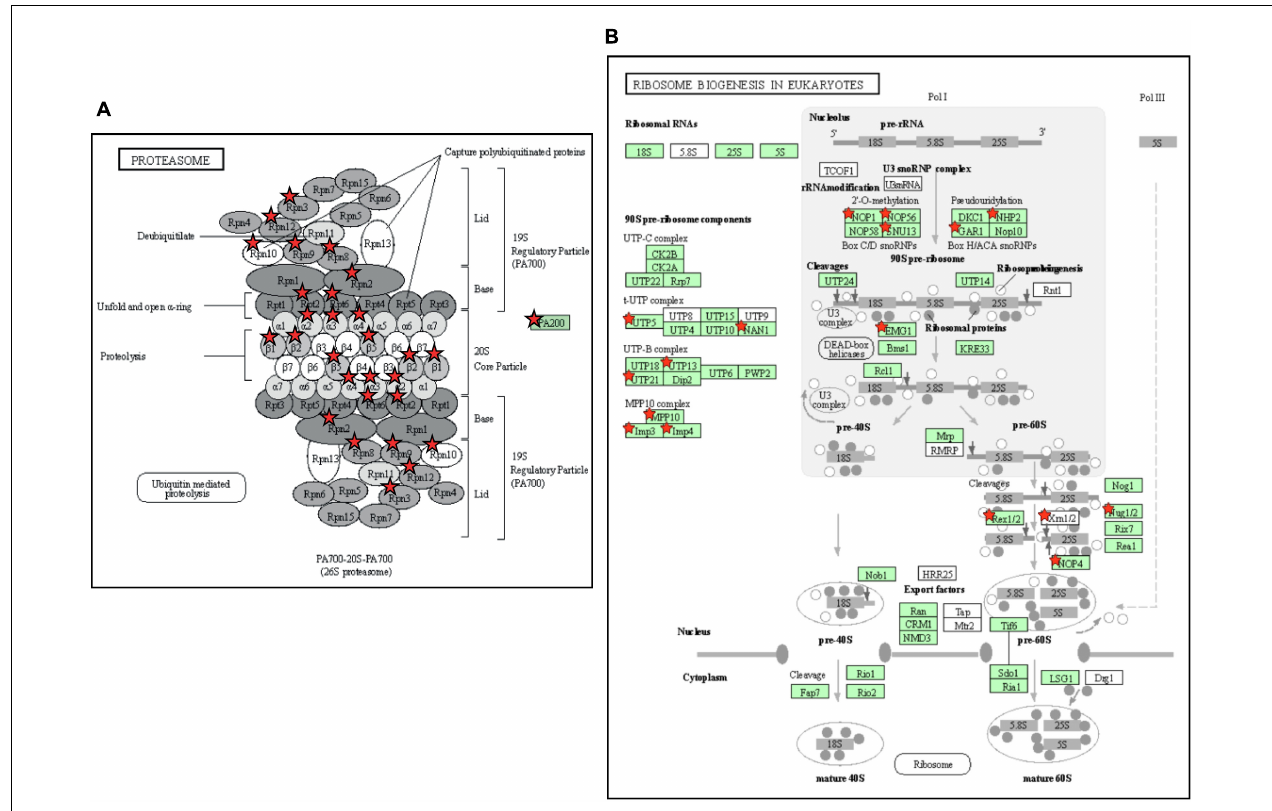
FIGURE 7 | Enrichment of pathways related to protein turnover in tomato fruit stored at 4 ◦ C. (A) The Proteasome pathway. The pathway was 10.3-fold enriched, with a P -value of 1.0e-11 and a False Discovery Rate of 7.4e-10. (B) The Ribosome Biogenesis in Eukaryotes pathway. The pathway was 6.2-fold enriched, with a P -value of 6.8e-9 and False Discovery Rate of 2.5e-7. Enriched KEGG pathways were identified using DAVID with 804 genes that exhibited a > 2-fold increase in expression at both 4 and 12 days of storage relative to Day 0. Genes present in the gene set are highlighted with a red star. The gene set can be found in Supplementary Table 5 . (To save space, panel A has been edited by moving the red stars from a separate table onto the proteasome cartoon. The original figure is shown in Supplementary Figure 5